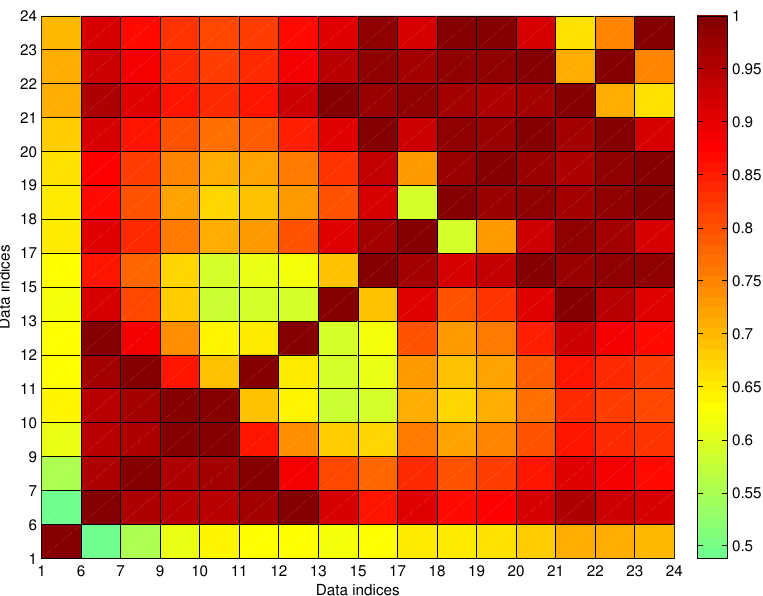
Figure 15. The fuzzy connecting MF matrix for the trajectory fragment after outlier elimination.